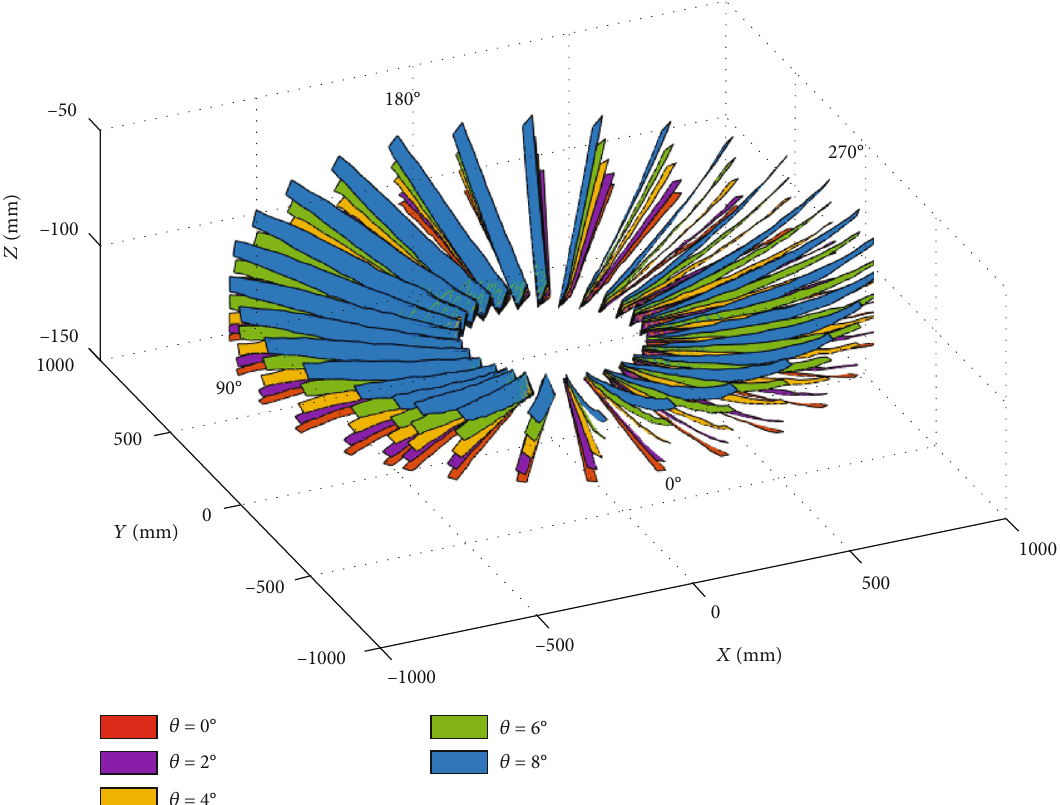
Figure 15: 3D reconstruction results of the measured rotor blade over its full rotating range at fi ve di ff erent collective pitch angles in hover fl